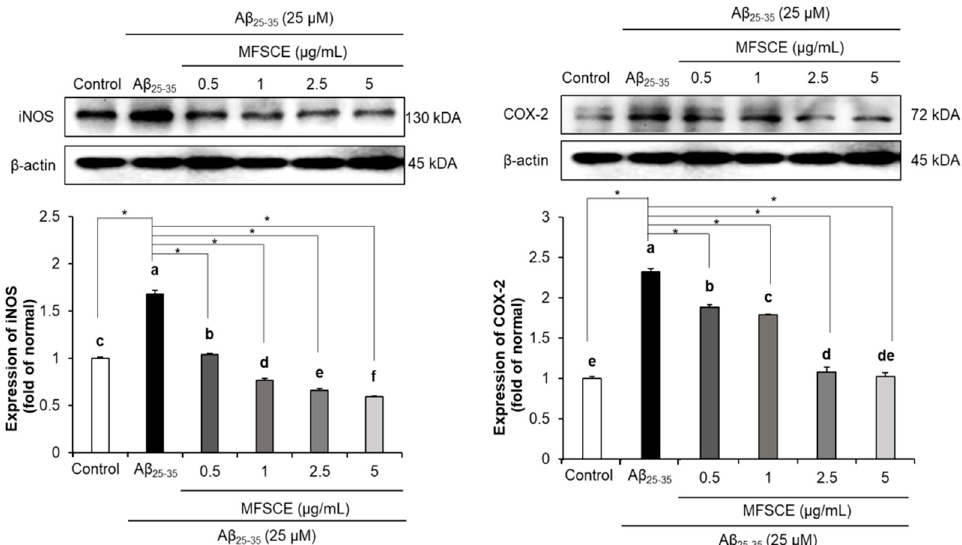
Figure 4. Effect of membrane-free stem cell extract (MFSCE) on neuroinflammation-related protein expression in SH-SY5Y cells treated with A β 25–35 . Values are presented as mean ± SD ( n = 6). The different letters (a–f) among groups represent significant differences determined by ANOVA and Duncan’s multiple range test (p < 0.05). * p < 0.05 vs. A β 25–35 -treated cells. β -actin was used as a loading control.